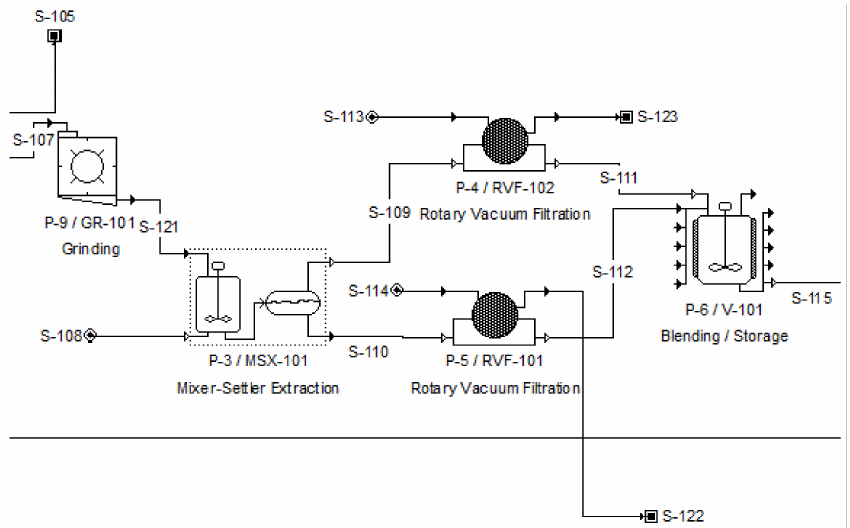
Figure 2. The main process of longevity spinach extract production.